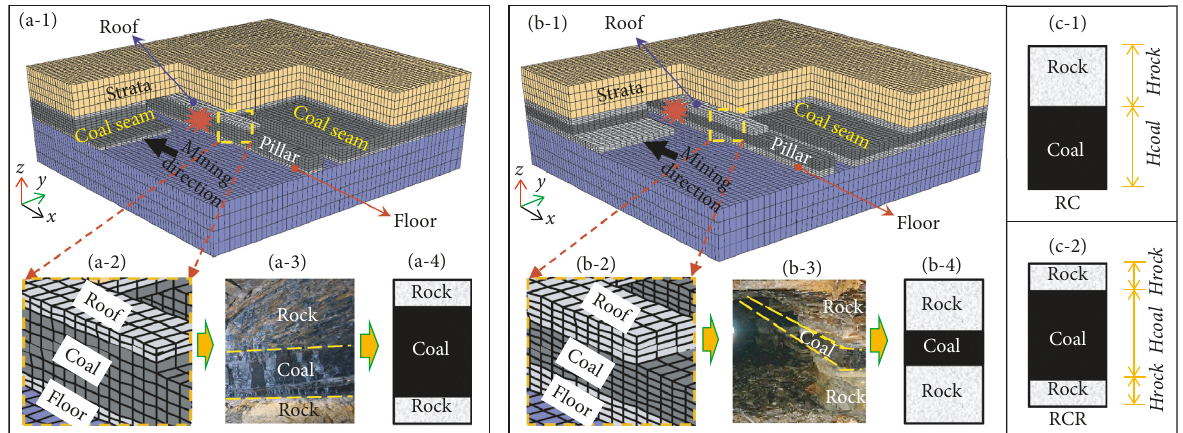
F IGURE 1: Coal pillars with two different geometries in longwall mining systems. The lower figures are in situ roof-coal-floor combinations and simplified RCR samples. (a-1) and (b-1) are the 3D schematics of longwall mining systems. (a-2) and (b-2) are the magnified figures of pillars. (a-3) and (b-3) are the two kinds of in situ roof-coal-floor structures with different height ratios. (a-4) and (b-4) are the schematics of RCR samples with different height ratios. (c-1) Rock-coal (RC) sample. (c-2) Rock-coal-rock (RCR) sample.